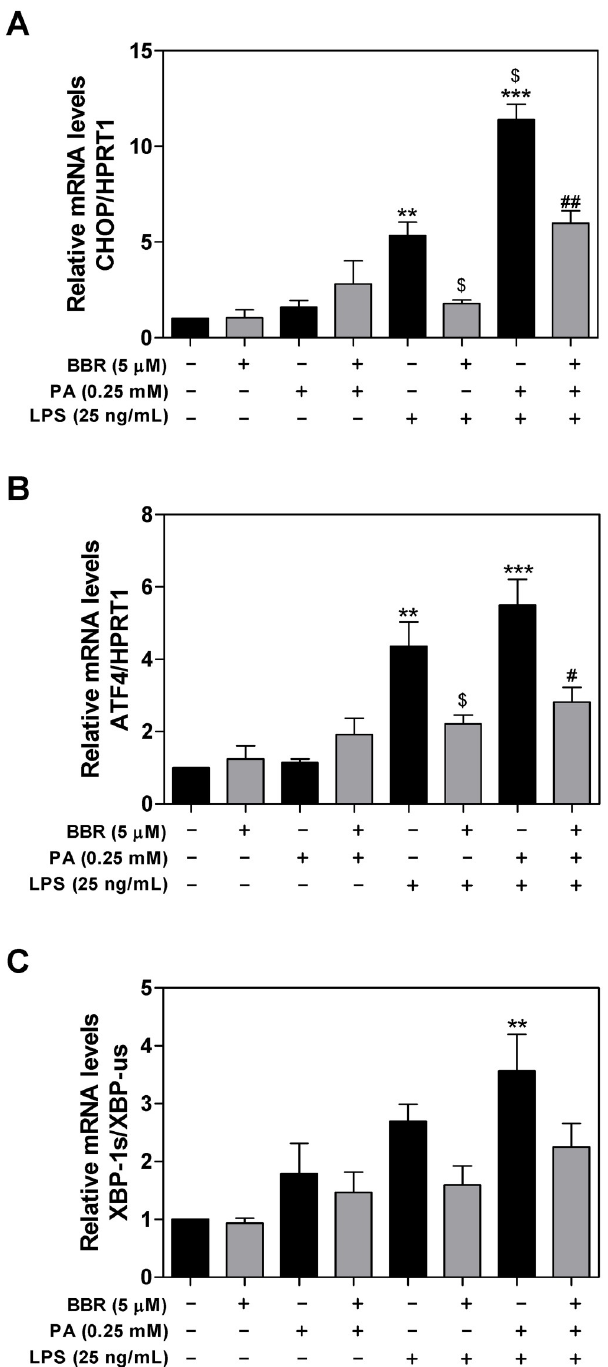
Fig 3. Effect of BBR on PA and LPS-induced mRNA expression of the UPR genes in RAW264.7 macrophages. RAW264.7 cells pre-treated with BBR (5 μ M) for 1 h, then treated with PA (0.25 mM) or LPS (25 ng/mL) or both for 6 h. The mRNA levels of CHOP, ATF4, XBP-1s, and XBP-1us were detected by real-time RT-PCR and normalized to HPRT1 as described under Materials and Methods. Values are mean ± S.E. of three independent experiments. Statistical significance relative to vehicle control, �� p < 0.01, ��� p < 0.001; relative to LPS, $ p < 0.05; relative to PA+LPS, # p < 0.05, ## p < 0.01. A . CHOP; B . ATF4; C . XBP-1s.